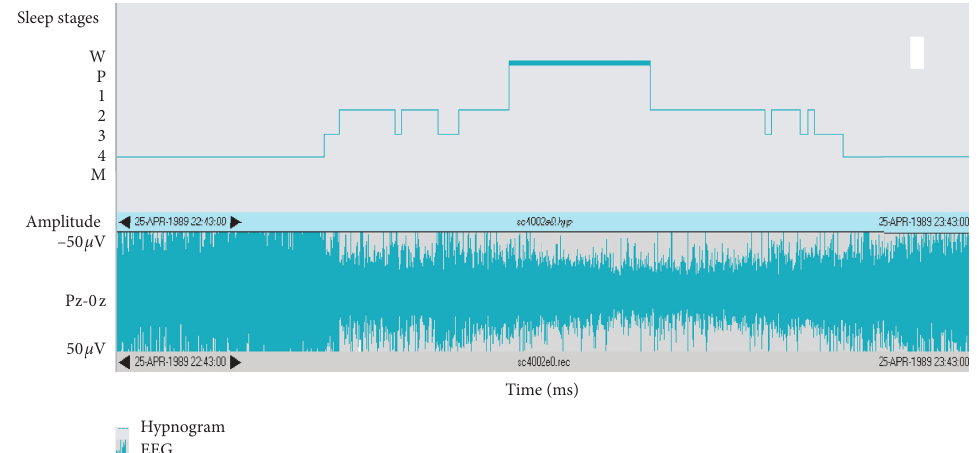
Figure 6: Electroencephalogram and manual marking results of Pz-Oz channels in the Polyman statistics.